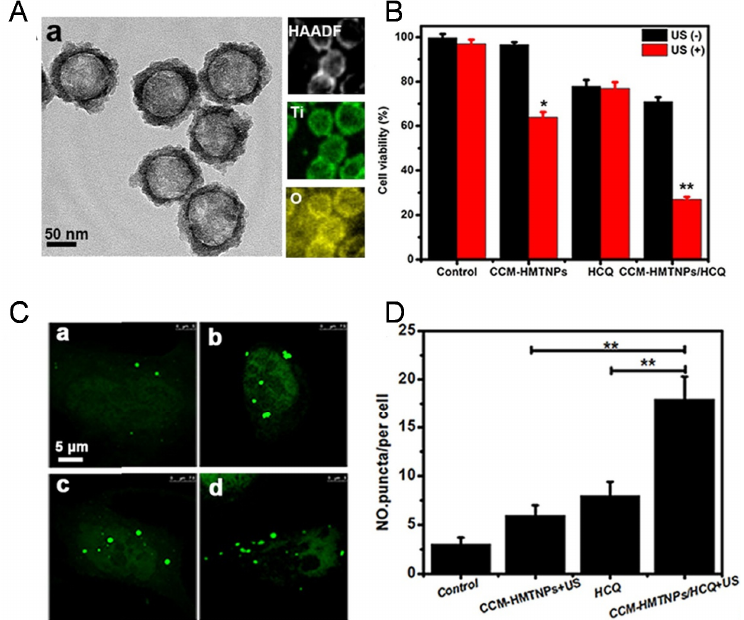
Figure 6. Enhanced SDT for therapeutic-resistant cancer by exploiting CCM-HMTNPs/HCQ. ( A ) TEM image ( left ) and the correspondent HAADF-STEM image ( right ) of HMTNPs, elemen- tal mapping showing the distribution of Ti (green) and O (yellow). ( B ) Cell viability of MCF-7 cells with different treatments under US irradiation (1 W cm − 2 , 30 s). Note: the control group represents the cells treated with PBS. The data points represent mean ± S.D. ( n = 6). The level of statistical significance is indicated when appropriate (* p < 0.05 versus control, ** p < 0.01 versus control). ( C ) Representative images and ( D ) quantification of eGFP-LC3-positive puncta of MCF-7 cells. Note: ( a ) Control group, ( b ) CCM-HMTNPs + US, ( c ) HCQ, and ( d ) CCM-HMTNPs/HCQ + US.